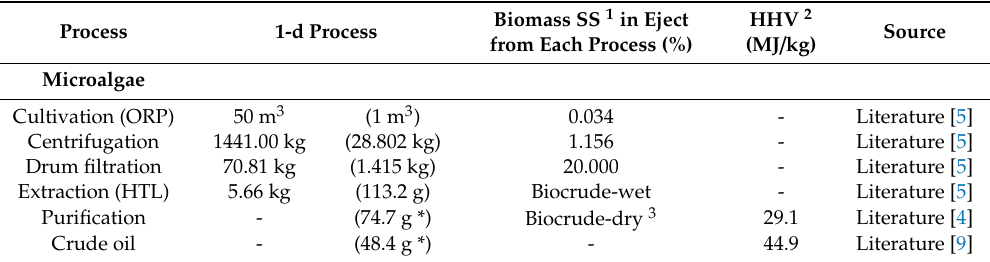
Table 1. Conversion ratio of microalgae to biocrude from the pilot plant located at Minamisoma. Process